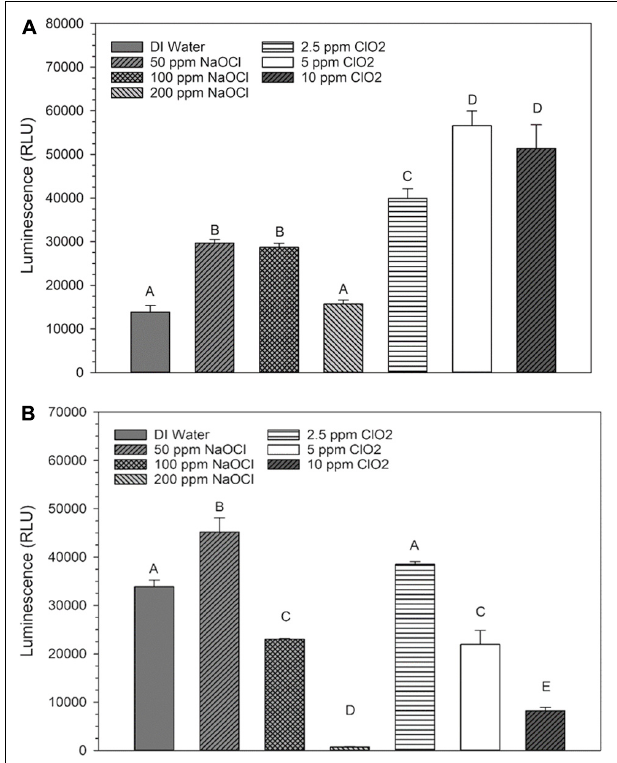
FIGURE 4 | Relative levels of NADP + (A) or NADPH (B) present in Escherichia coli O157:H7 after treatment with NaClO or ClO 2 . Data are presented as means ± standard deviations, and significant differences ( P ≤ 0.05) in relative luminosity units (RLUs) observed after each treatment are represented by different letters (e.g.,